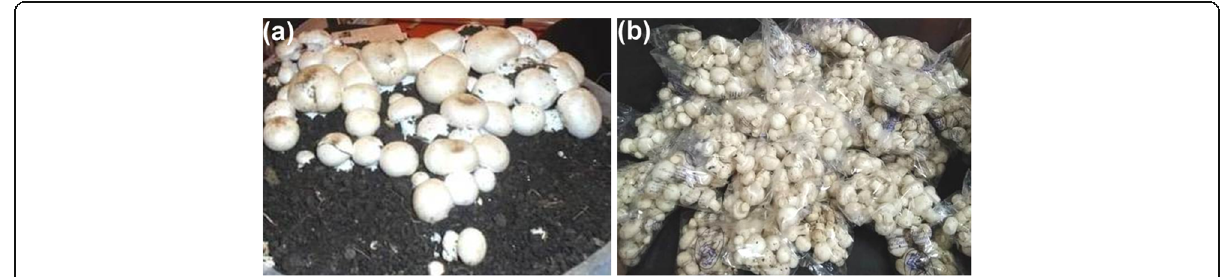
Fig. 1 The Agaricus bisporus (button mushroom) a at cropping stage and b packed in polythene bags